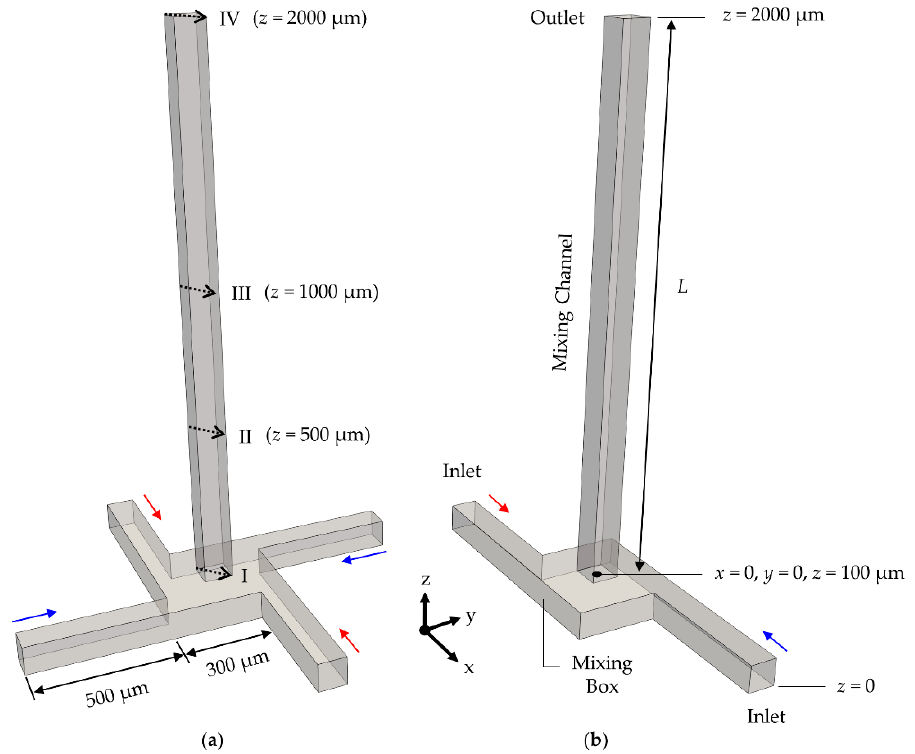
Figure 3. Swirl-generating passive micromixers: ( a ) four-inlet design and ( b ) two-inlet design. Dashed Figure 3. Swirl ‐ generating passive micromixers: ( a ) four ‐ inlet design and ( b ) two ‐ inlet design. Dashed arrow lines I, II, III, and IV are edge-to-edge on the x-y plane at different z -heights; z = 100, 500, 1000, arrow lines I, II, III, and IV are edge ‐ to ‐ edge on the x ‐ y plane at different z ‐ heights; z = 100, 500, 1000, and 2000 µ m respectively. and 2000 μ m respectively.